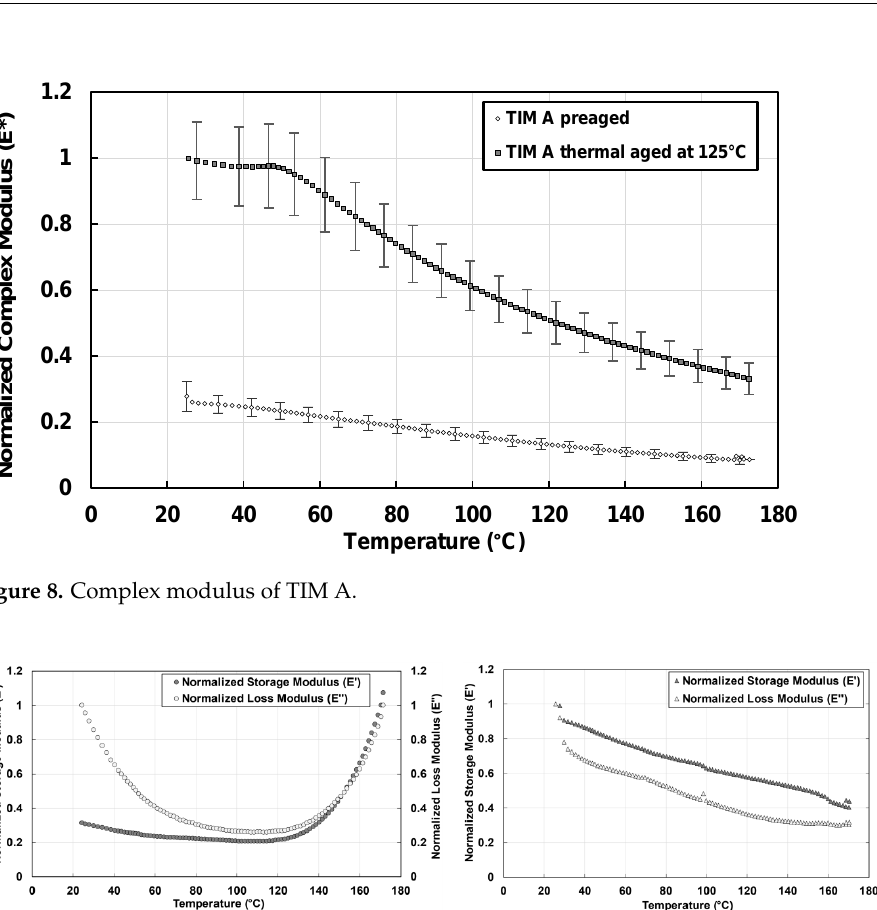
Figure 8. Complex modulus of TIM A.